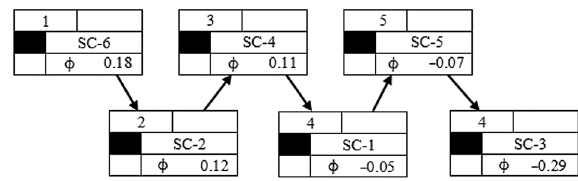
Table 6. PROMETHEE flows Alternatives